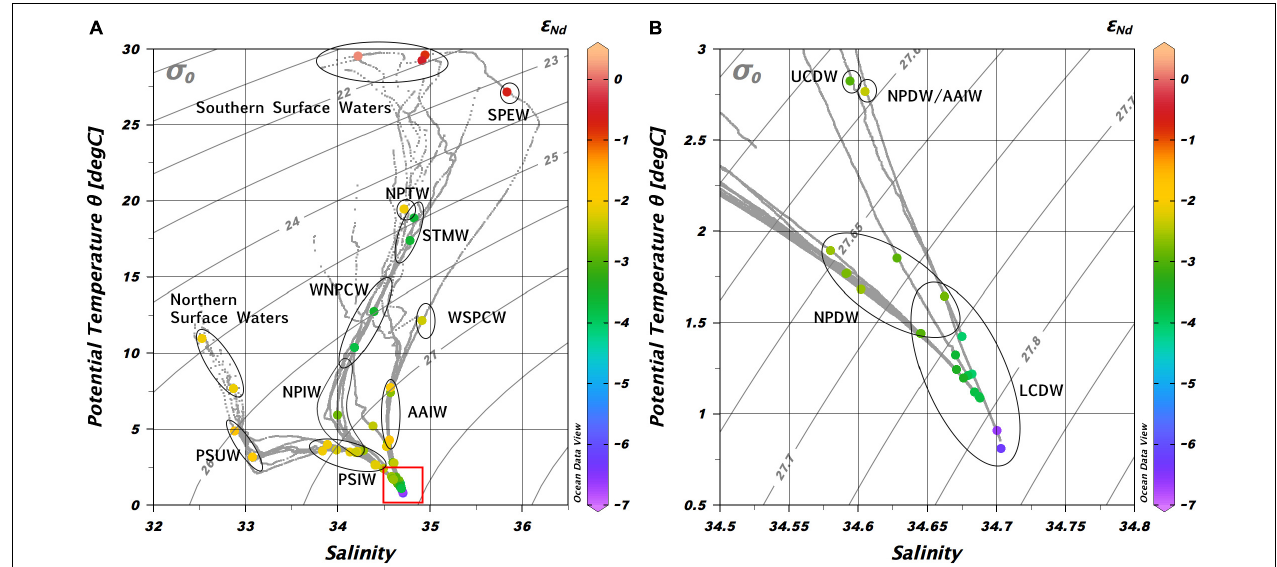
FIGURE 2 | (A) Salinity vs. potential temperature plots for all stations including color-coded ε Nd signatures from each sample. (B) Close-up of the red square in (A) . The water mass classification is based on hydrographic properties defined in Table 1 . Created by using Ocean Data View (Schlitzer, 2020) and further modified.